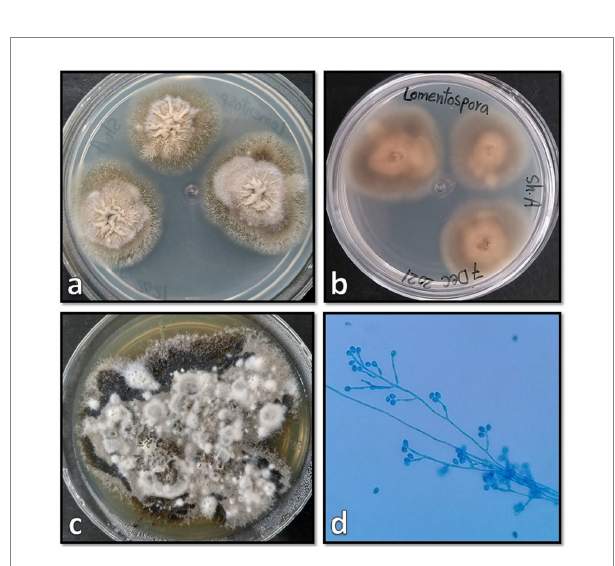
FIGURE 4 Surface and reverse of the isolated Lomentospora prolificans colony on Sabouraud dextrose agar after 4 days (A,B) , and after 20 days (C) incubation at 25 ° C when the mature colonies became dark gray to black and developed white mycelial tufts, and its microscopic morphology (D)